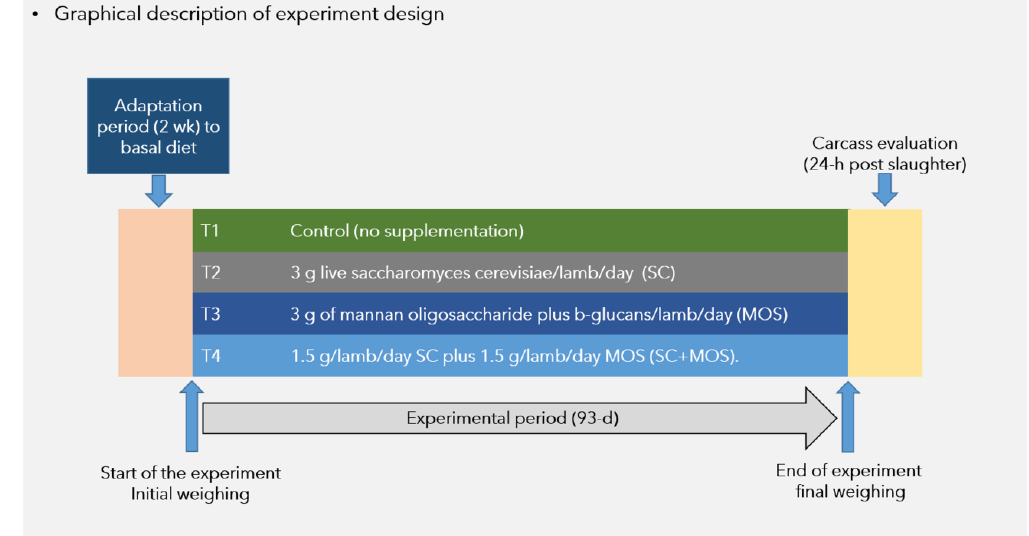
Figure 1. Description of assigned treatments and times for weight registration during experimental period and carcass evaluation. Table 1. Composition of experimental diets offered ad libitum to the lambs.